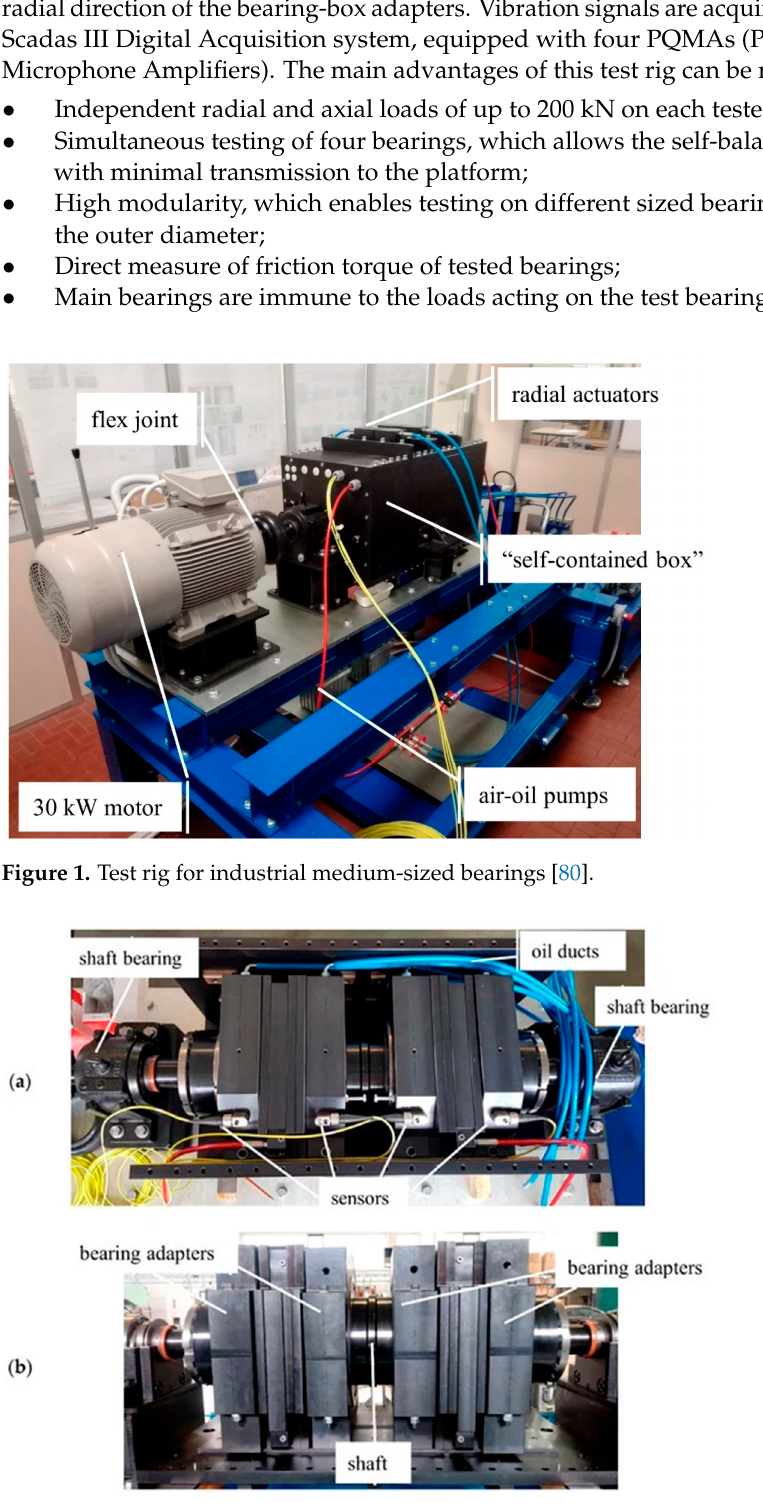
Figure 2. Interior of the “self-contained box” [80]: ( a ) top view; ( b ) front view.